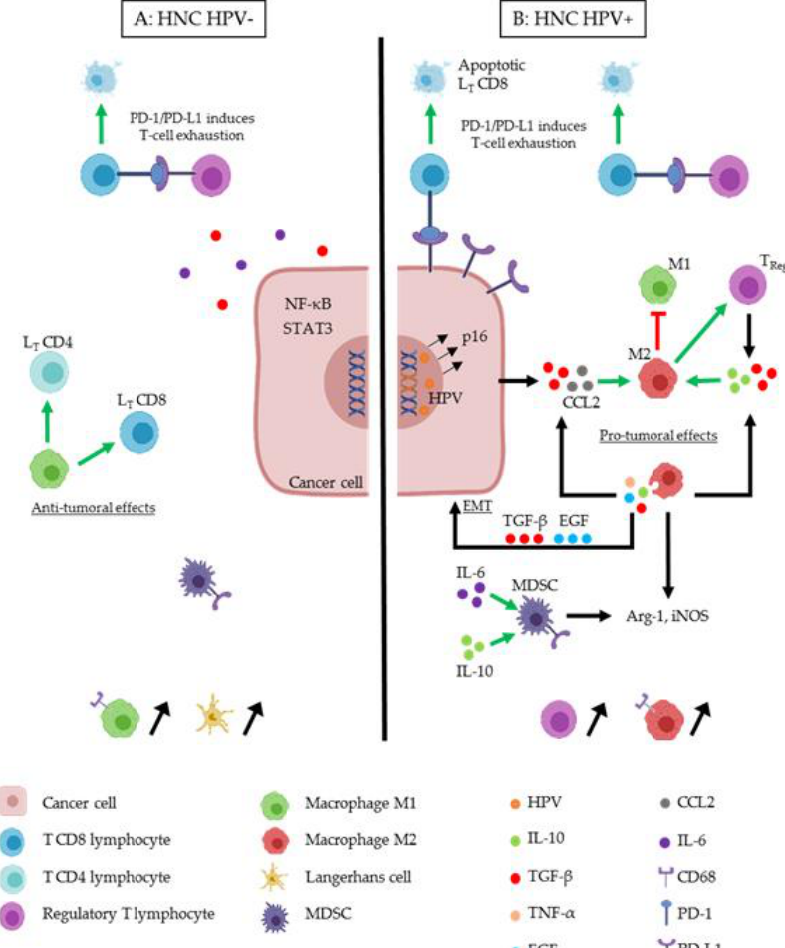
Figure 1. Immune cells interactions in the tumor microenvironment of head and neck cancer (HNC) HPV − ( A ) and HNC HPV + ( B ). Cancer cells can modify the tumor microenvironment (TME), in order to induce immunosuppression. Several actors play an essential role. (A) M1 macrophages (green cell) induce anti-tumoral e ff ects by activating LT CD4 (light blue cell) and LT CD8 (dark blue cell). In the TME of HNC HPV-, IL-6 (purple round) and TGF- β (red round) are secreted in order to induce immunosuppression like the expression of transcription factors (NF- κ B and STAT3). TReg cells (purple cell) act as an immunosuppressive cell by inducing T-cell exhaustion. TReg express PD-L1 which binds to its receptor, PD-1, and induces LT CD8 apoptosis, this phenomenon appears also in HPV + TME (B). M1 macrophages and Langerhans cells (yellow cell) are more present in the TME of HNC HPV-. (B) HPV (orange circle) infect HNC cell and integrate the host cell genome. This induces the expression of oncoproteins and the overexpression of p16. M2 macrophages (red cell) are predominant in this TME. TGF- β and CCL2 (grey circle) secreted by the HPV + cancer cell act to di ff erentiate macrophages in the M2 phenotype, which acts as a pro-tumoral immune actor. M2 inhibit M1 and stimulate TReg cells. M2 secrete TGF- β , IL-10 (green round) and IL-6, which induce a feedback on its stimulation, but also TGF- β and EGF (blue round), which induce epithelial to mesenchymal transition (EMT) on cancer cells. IL-6, and IL-10 stimulate myeloid-derived-suppressor cells (MDSC) cell (dark cell), which secrete Arg-1 and iNOS like M2 macrophages.